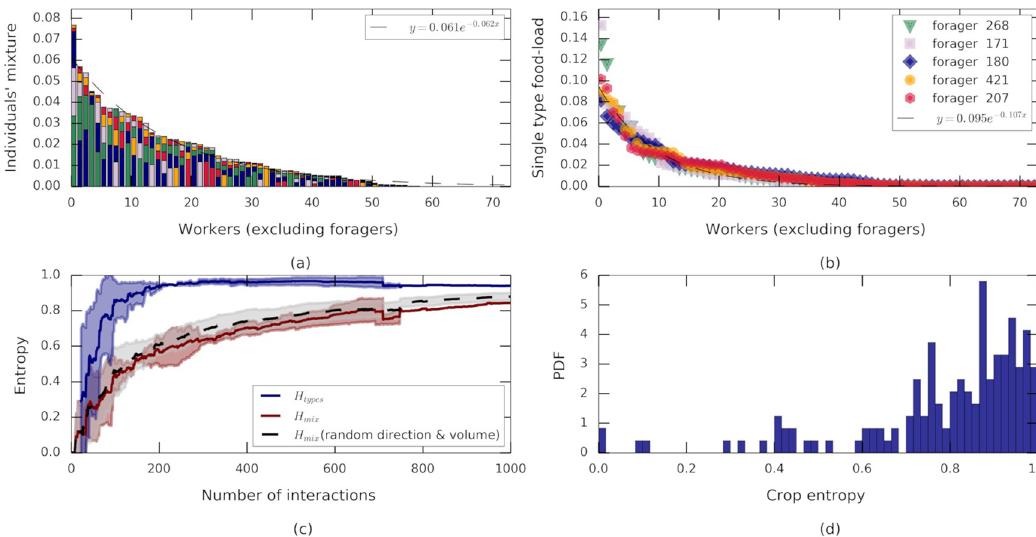
Fig 2. Food spread and source blending across the colony. (a) The amount of food held by each non-forager ant a at the end of the experiment, P ( a ),partitioned into conditional probabilities P ( f | A = a ) by forager origin ( f = 268, green, f = 171 purple, f = 180 blue, f = 421 orange, f = 207 pink; vertically ordered by amounts received). Ants are ordered by the amount of food in their crop, and the dashed line is an exponential fit y = ae − bx , a = 0.061 ± 0.002, b = 0.062 ± 0.003, R 2 = 0.96. For colonies B and C see S2 Fig. (b) The extent to which food from each forager f (color code as in panel a) was distributed among non-forager ants a : P ( a | F = f ). Recipient ants are ordered (per forager f ) by amount received. Dashed curve is an exponential fit y = ae − bx , a = 0.095 ± 0.0013, b = 0.1 ± 0.002, R 2 = 0.97. For colonies B and C see S2 Fig. (c) Mixing entropies as a function of the number of trophallactic interactions starting from the first return of a loaded forager. Entropies are normalized by log ðj F jÞ to allow for data averaging over the three experiments. Lines are the mean over three experiments while shaded areas designate standard deviations. Depicted are the empirical entropy associated with the different proportions of food as brought in by each forager H types (blue), the empirical mixing entropy over all non-forager ants H mix , (red) and the mixing entropy for hybrid simulations where randomized interaction volumes and transfer directions were simulated over the empirical interaction schedule ( N = 30, shaded area depicts standard deviation of the outcomes). Discontinuities are a consequence of the variable number of interactions among the three experiments. (d) A histogram of normalized individual mixing entropies of all non-forager ants, h a = log ðj F jÞ , at the end of the experiments (all three experiments, N = 203 mix